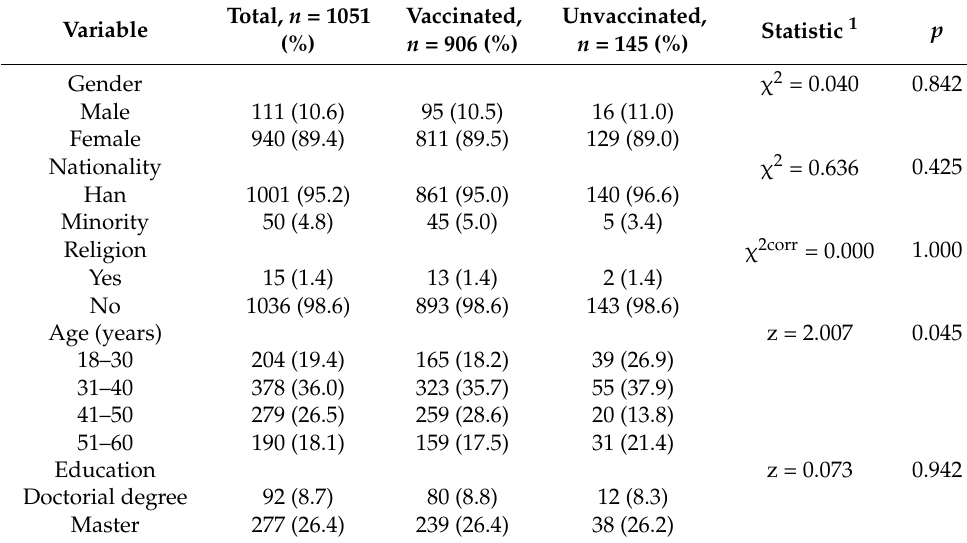
Table 1. Sociodemographic characteristics of